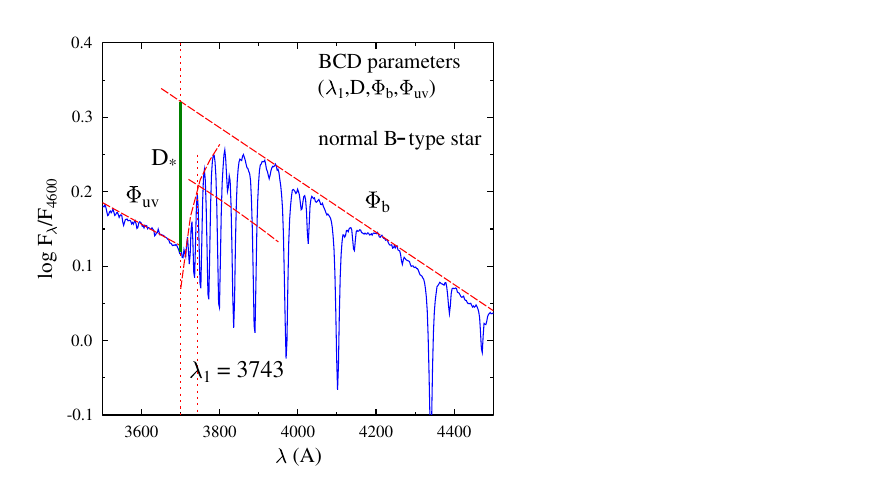
Figure 1. Graphical explanation of the BCD spectrophotometric parameters ( D , λ 1 , Φ b , Φ uv ) deter- mination for a B-type normal star. The photospheric D ∗ (heavy full line) and the λ 1 parameters are indicated. The slopes that define the gradients Φ uv and Φ b are also indicated. The spectrum was obtained in the Complejo Astronómico El Leoncito (CASLEO), San Juan, Argentina. Adapted from Aidelman et al. [10].